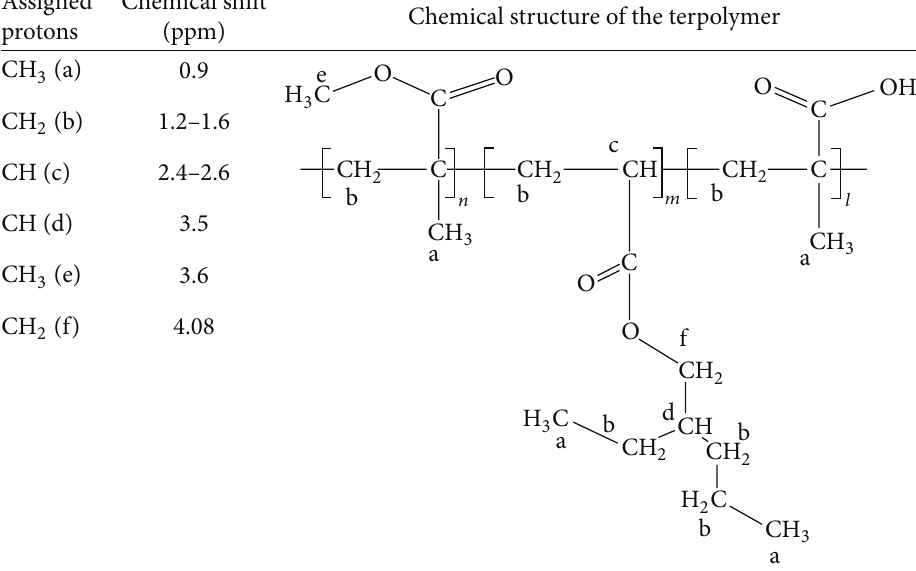
Figure 3: 1 H NMR chemical shifts of the prepared